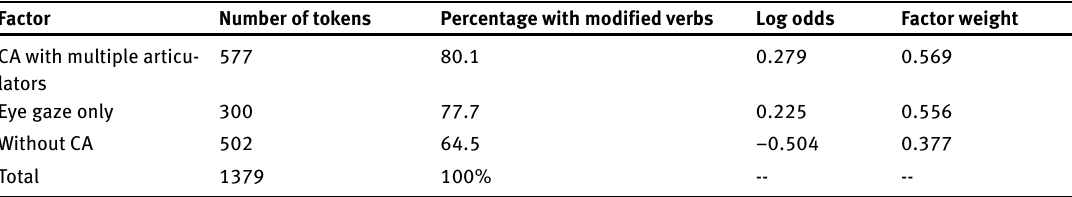
Table 5. Constructed action and eyegaze correlating with modification of indicating verbs Factor